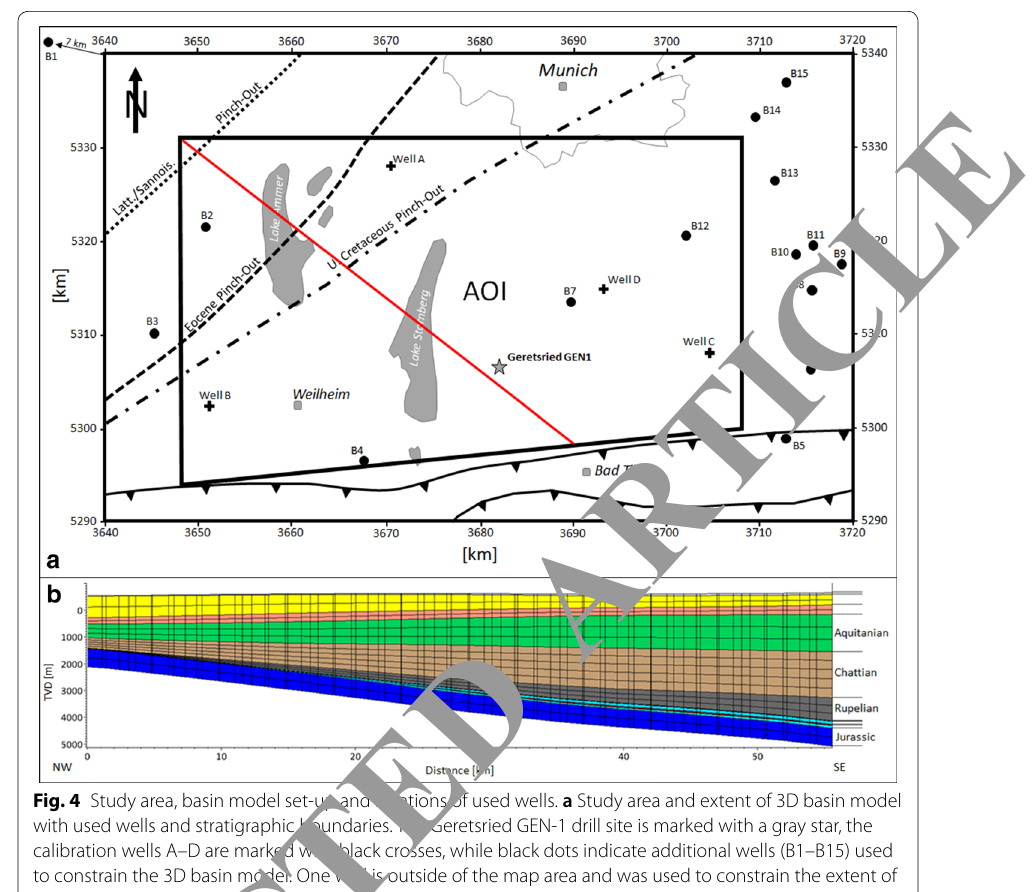
Fig. 4 Study area, basin model set-up and locations of used wells. a Study area and extent of 3D basin model with used wells and stratigraphic boundaries. The Geretsried GEN-1 drill site is marked with a gray star, the calibration wells A–D are marked with black crosses, while black dots indicate additional wells (B1–B15) used to constrain the 3D basin model. One well is outside of the map area and was used to constrain the extent of the Lattorf/Sannoisian. The map coincides with the extent of the full basin model, which has been reduced to an area of interest (AOI, marked by the black lined polygon) after simulation. According to the used well data, pinch-outs towards the north-western part of the study area have been incorporated into the 3D basin model for Upper Cretaceous (dashed–dotted line), Eocene (dashed line) and Lattorf/Sannoisian (dotted line). The red line marks a cross section represented in b . b NW–SE cross section through the basin model showing the individual layers, sublayers and incorporation of pinch-outs. Vertical scale in true vertical depth (TVD) in meters. The section is vertically exaggerated by a factor of